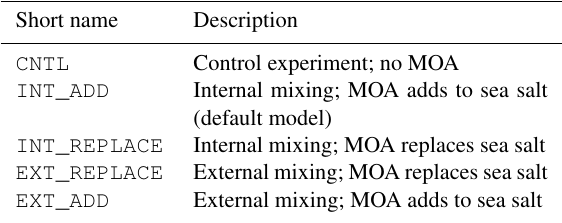
Table 3. Simulation sensitivity